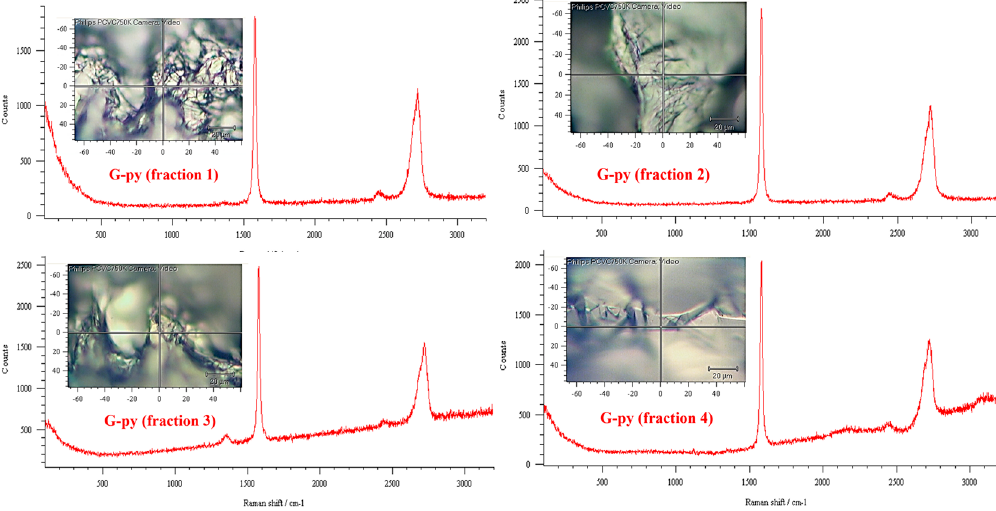
Figure 1. Raman spectral mapping of functionalized G-py nanofiller.